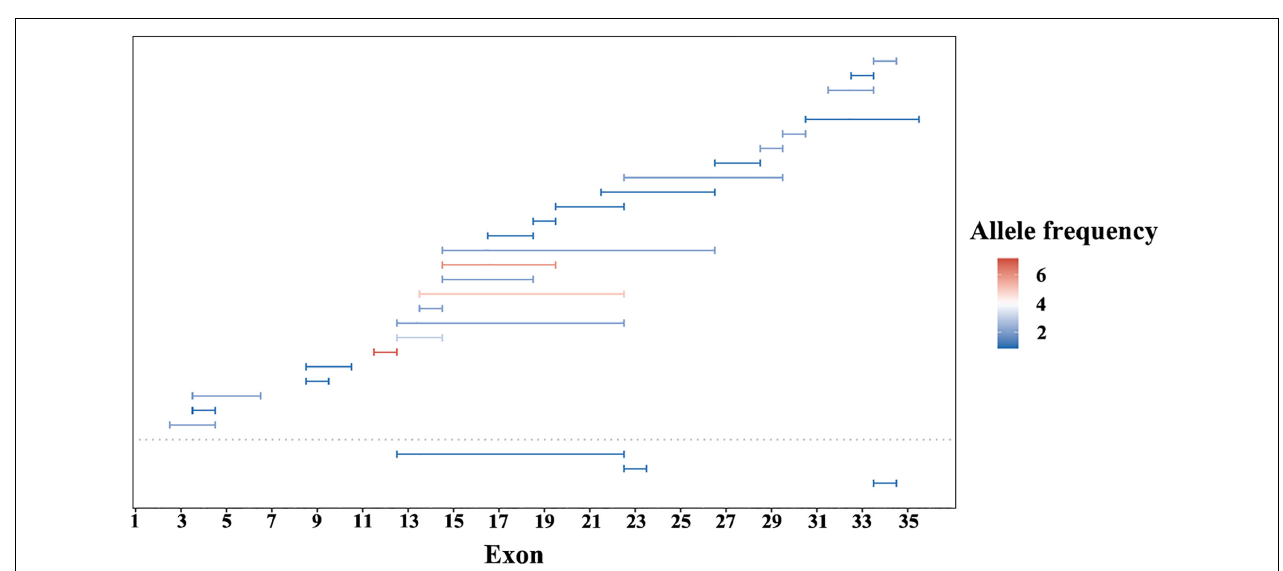
FIGURE 2 | Copy number variations (CNV) of EYS gene in this study. CNV in G1 cohort under the dotted line and G2 cohort above. Lengths of the horizontal line represents the CNV range. Color from blue to red indicate an increase in allele frequency.